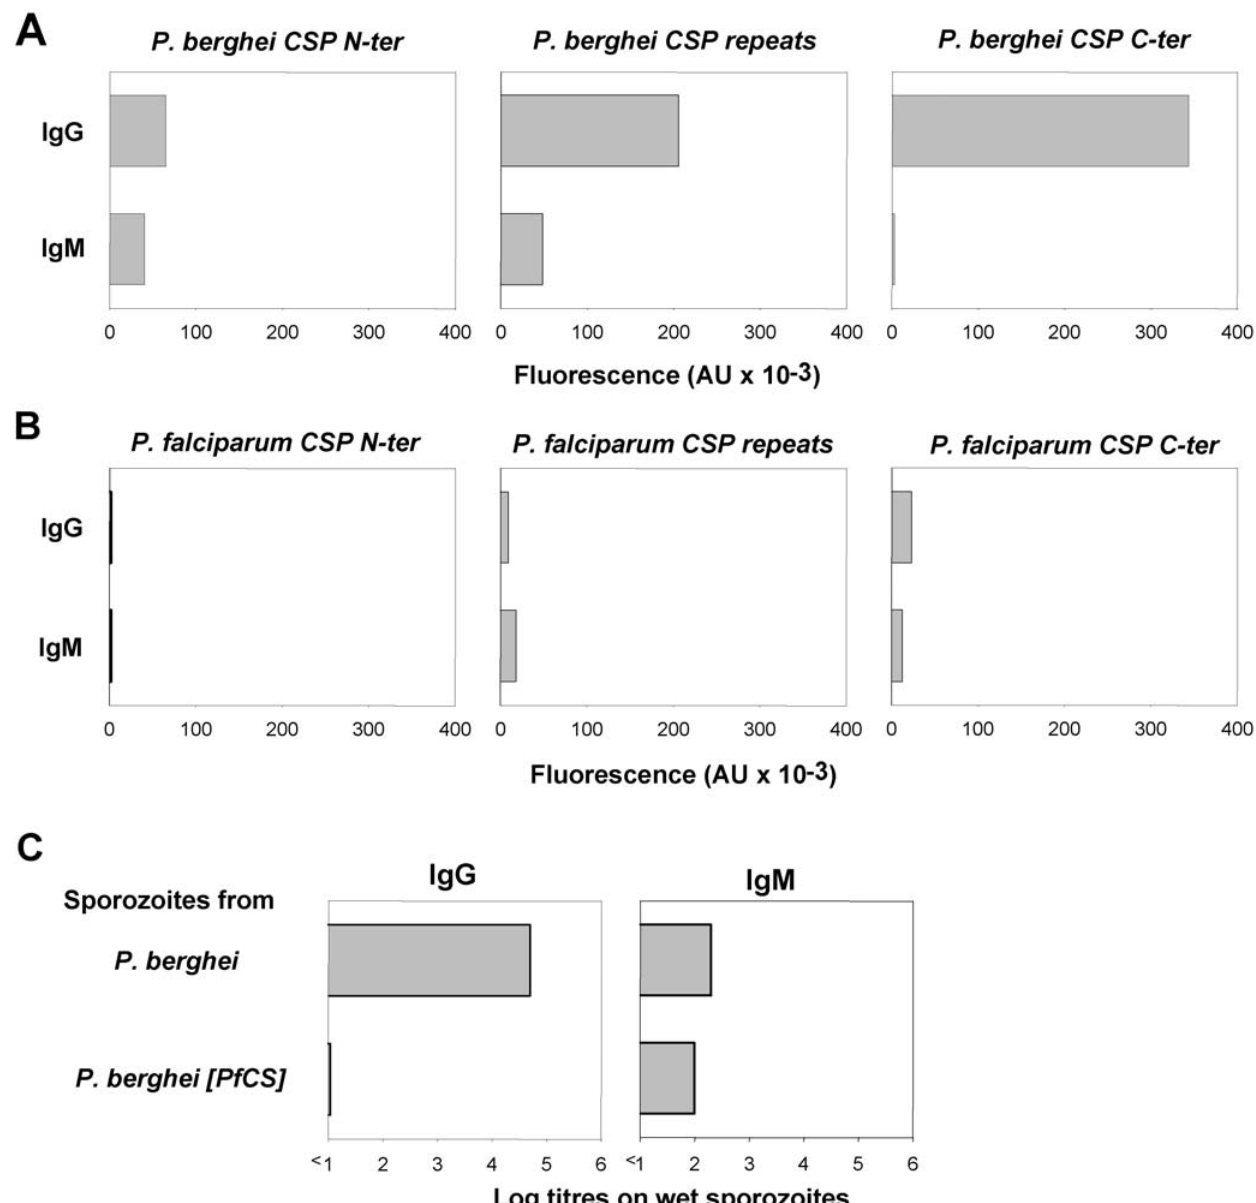
Figure 3. Antibody reactivity induced by immunization with irradiated sporozoites. Pooled serum samples from groups of mice immunized with sporozoites from the different parasite lines were analyzed by ELISA to assay IgG and IgM responses induced against P. berghei CSP (A), or P. falciparum CSP (B), using long peptides covering the N-terminus or the C-terminus of the antigen, and short peptides that include some of the repeat units of the central repetitive region. Serums were also tested by IFAT against wet sporozoites to detect anti-CSP IgG and IgM antibodies(C). Titres are expressed as the log of the highest dilution of serum giving a positive staining.